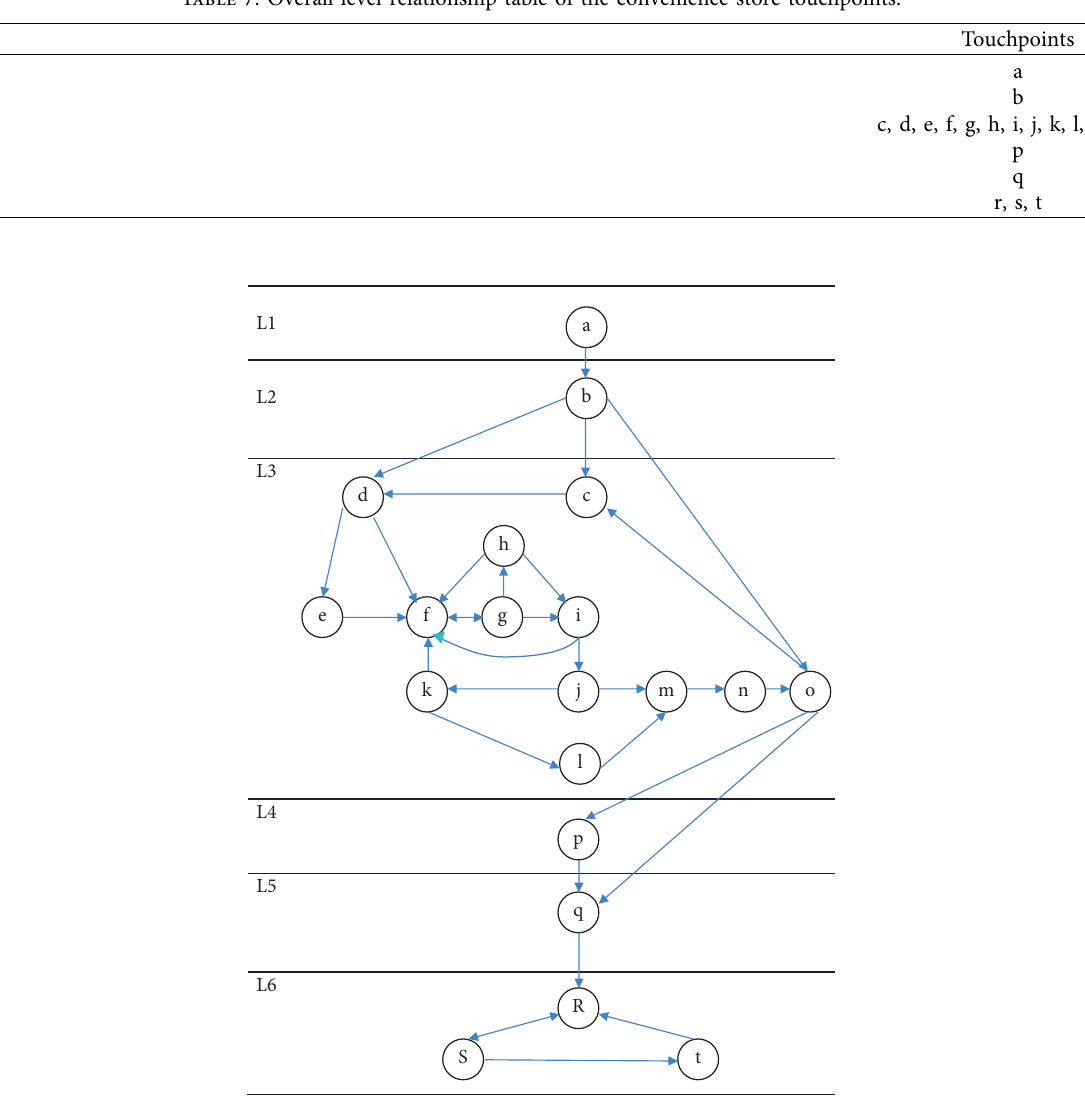
Figure 8: The directed graph of the optimized convenience store